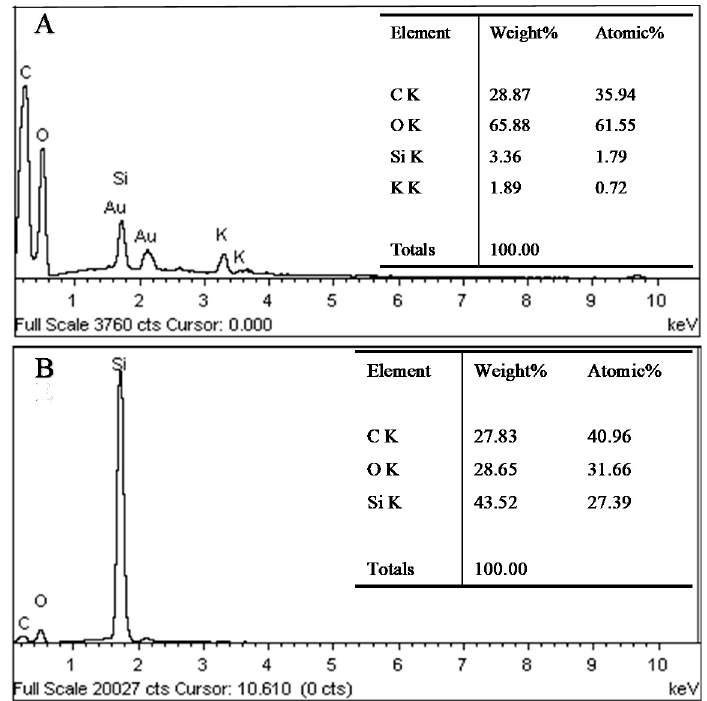
Figure 7. The EDS analysis of wood samples on tangential section ( A ) untreated wood and ( B ) PDMS@wood.